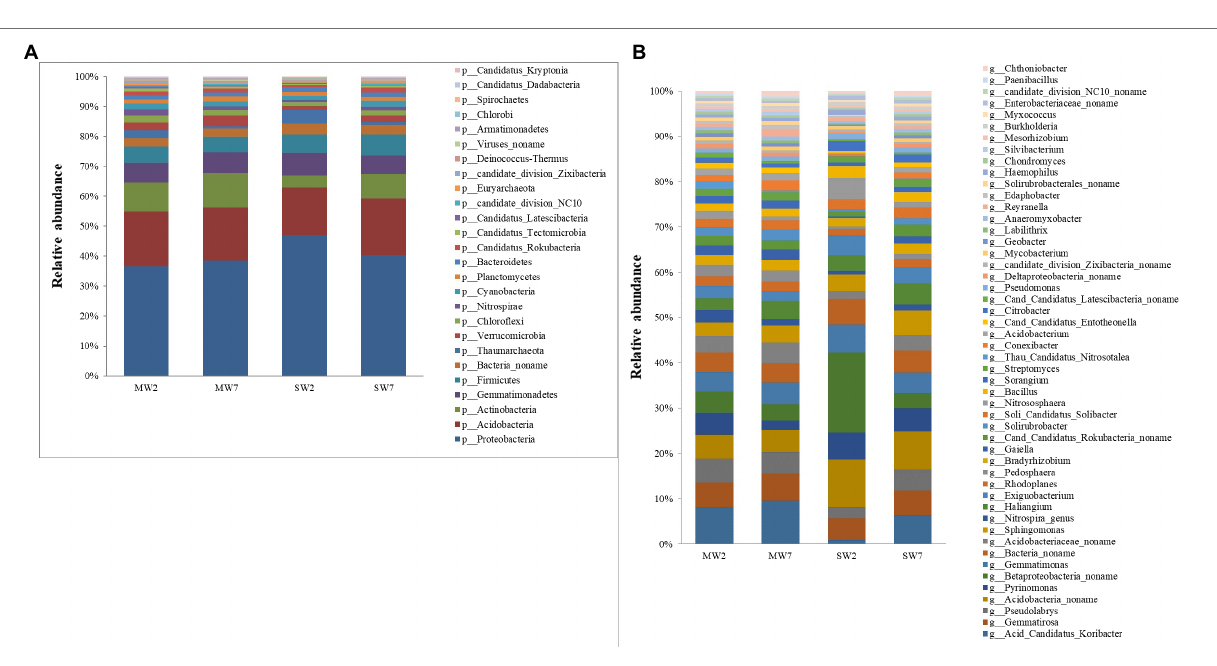
FIGURE 3 | The relative abundances of soil bacterial community composition at phylum (A) and genus (B) level in the